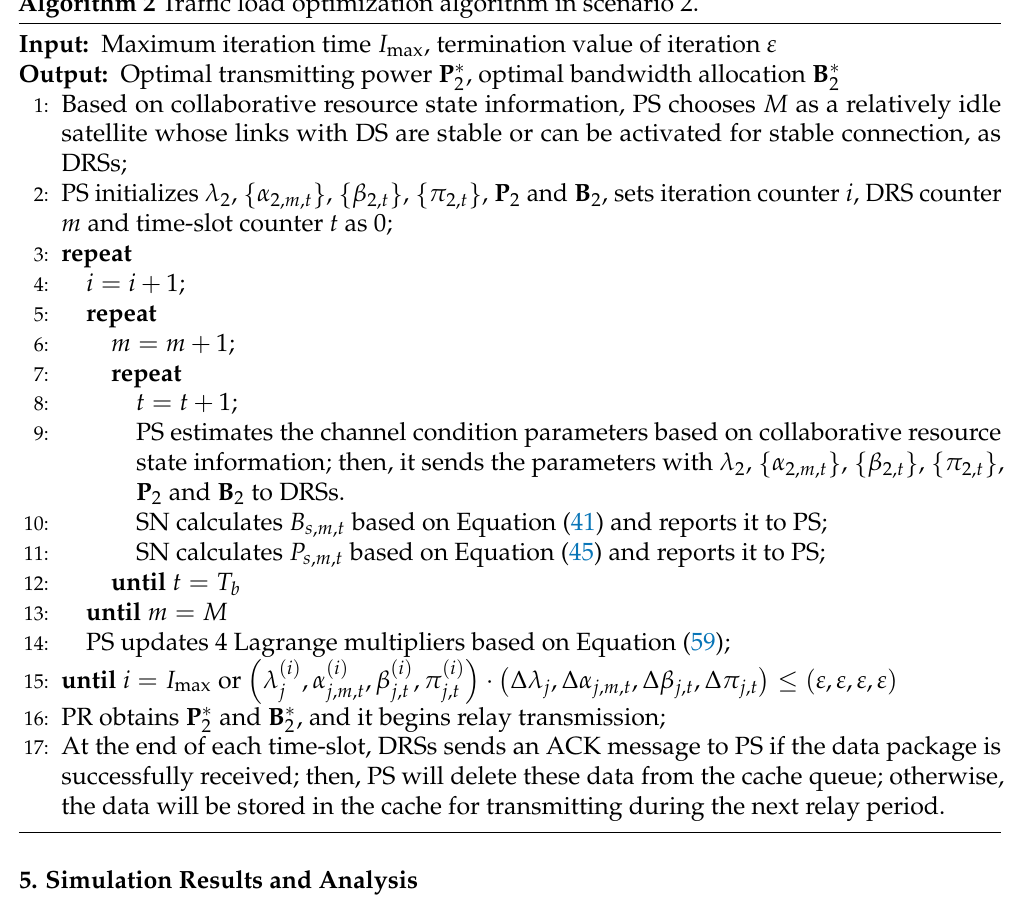
Algorithm 2 Traffic load optimization algorithm in scenario